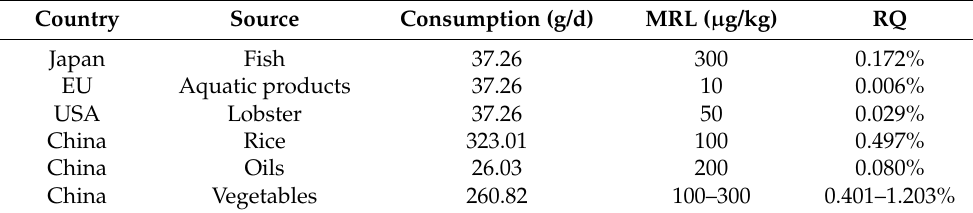
Table 9. The dietary risk of Chinese people according to MRL in different